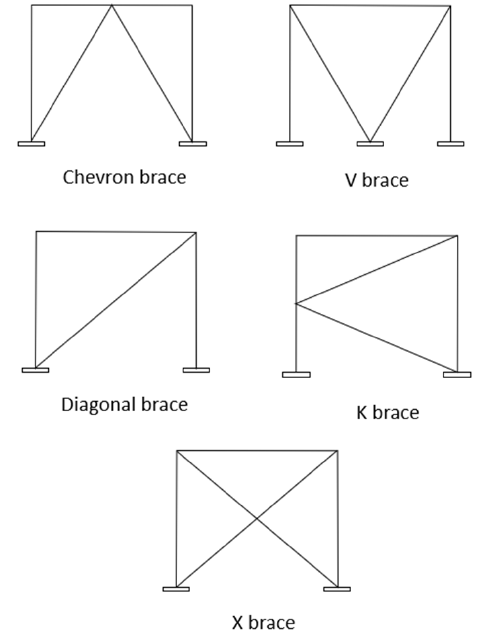
Figure 2. Types of concentric braces. (Sketch by K. Al-Kodmany; adapted from [10]).